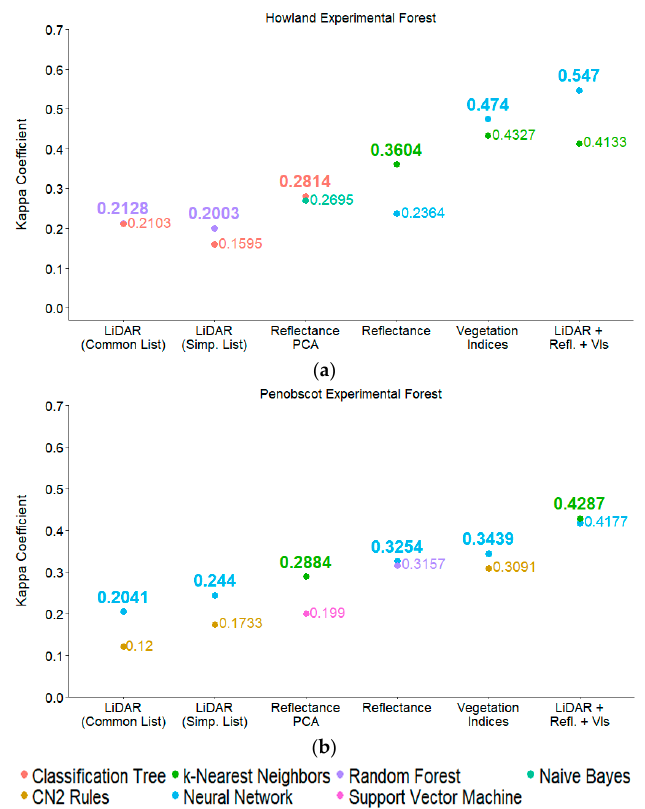
Figure 5. Kappa coefficients achieved by machine learners run on simplified datasets from Howland Experimental Forest ( a ) and Penobscot Experimental Forest ( b ). Dot color represents the machine learning technique used in each case.